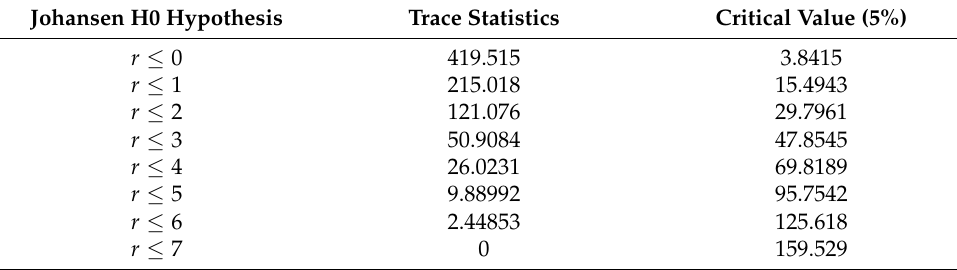
Table 5. Johansen test results for industrial